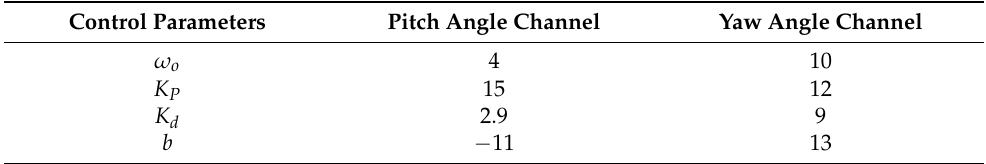
Table 4. Control parameters of the pitch and yaw angle channels.